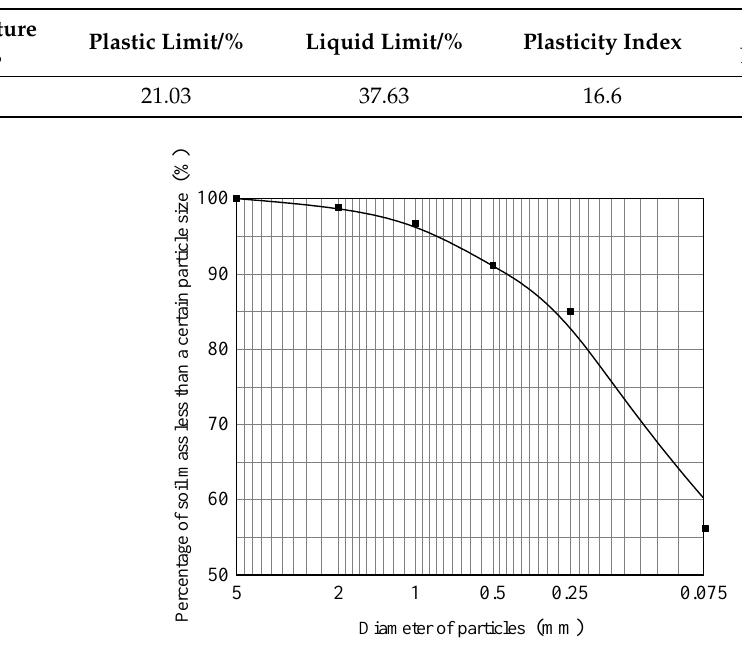
Table 1. Physical Properties of Silty Clay.